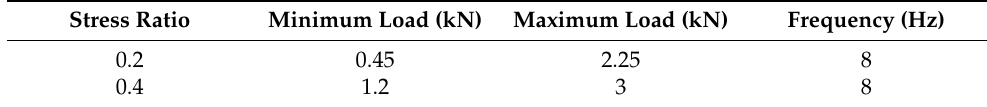
Table 3. Fatigue crack’s growth-test